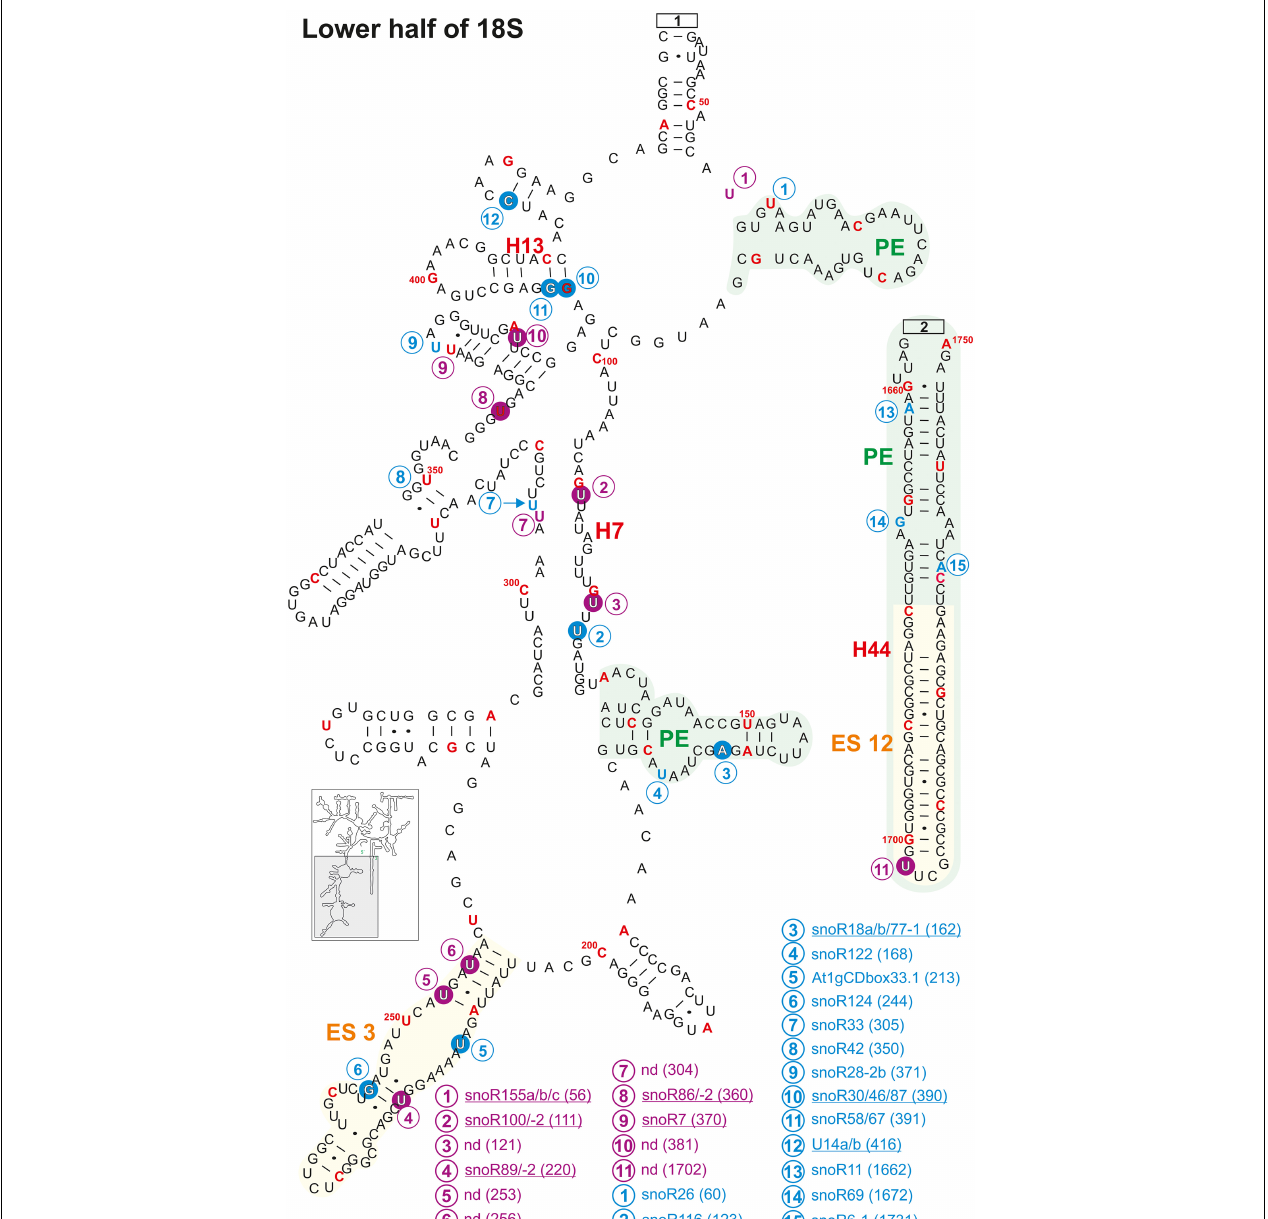
FIGURE 9 | Continuation of the secondary structure diagram of the 18S rRNA (At2g01010) of A. thaliana according to The RNAcentral Consortium (2019). All informations are listed in the legend of Figure 8 . The number in brackets correspond to the modified nucleotide position. A small illustration of the whole 40S rRNA secondary structure highlighting the according region is